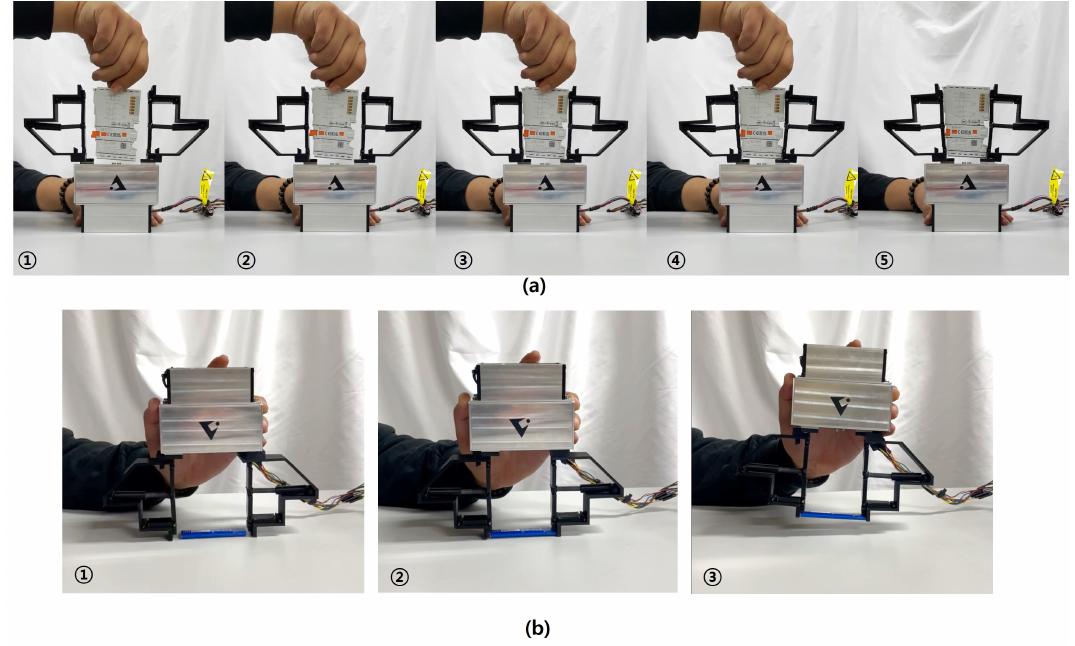
Figure 13. Sequential steps of pinch grasp. ( a ) An electronic part grasping (Mass: 50 g, size: 66.4 × 98.82 × 11.75 mm). ( b ) A thin plastic card grasping (Mass: 4 g, size : 20 × 78.6 × 6.3